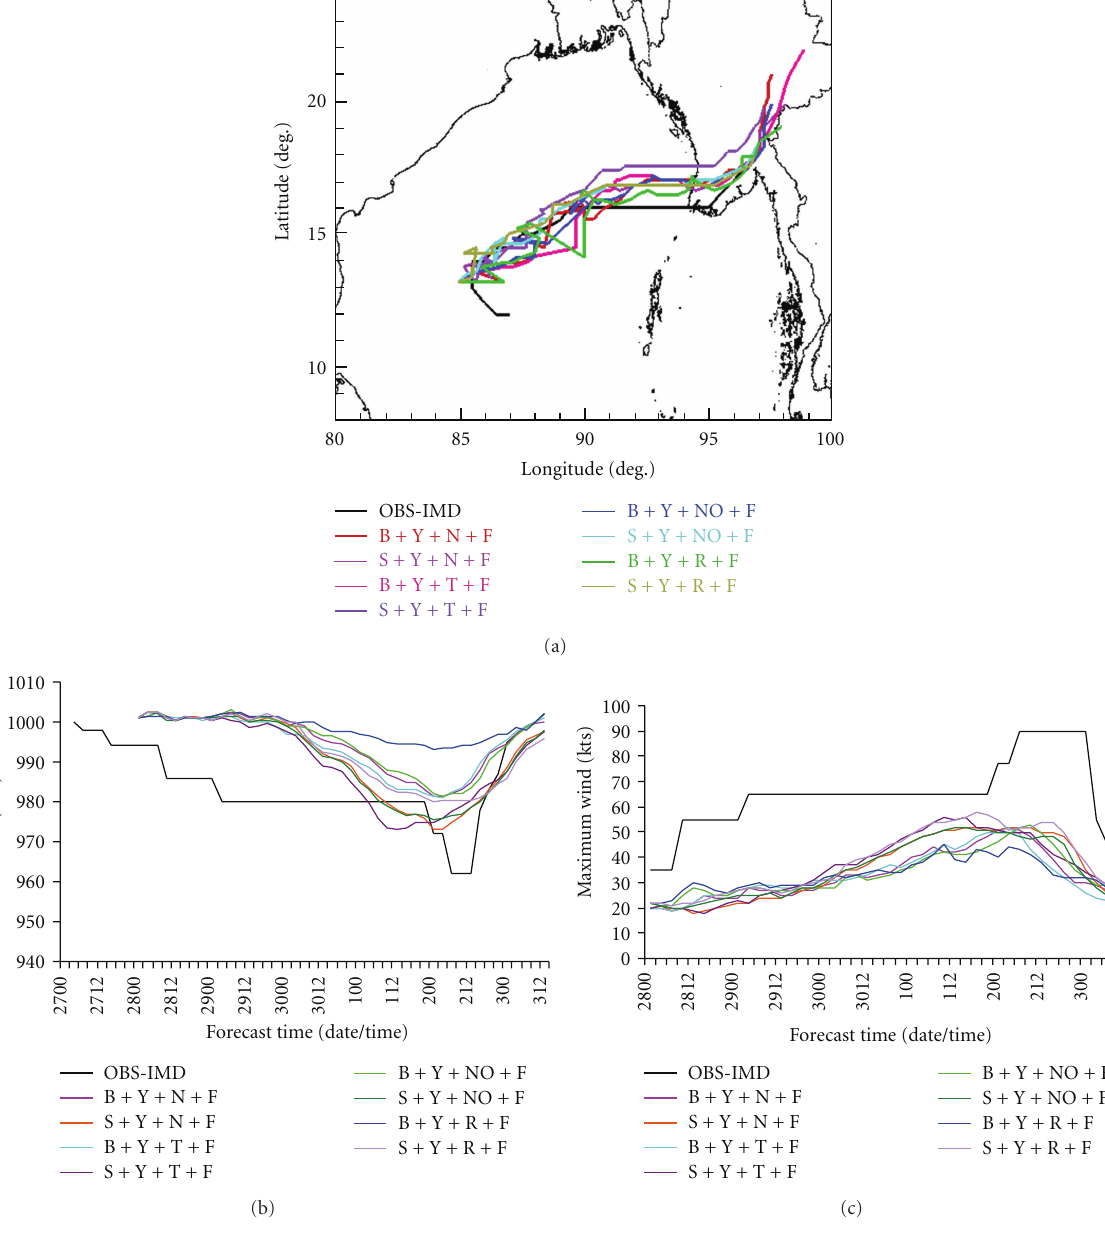
Figure 4: (a) Track, (b) MSLP (hPa), and (c) maximum wind (kts) of the cyclone NARGIS with two best cumulus convections, best PBL, 4 di ff erent land surface schemes, and Ferrier microphysics